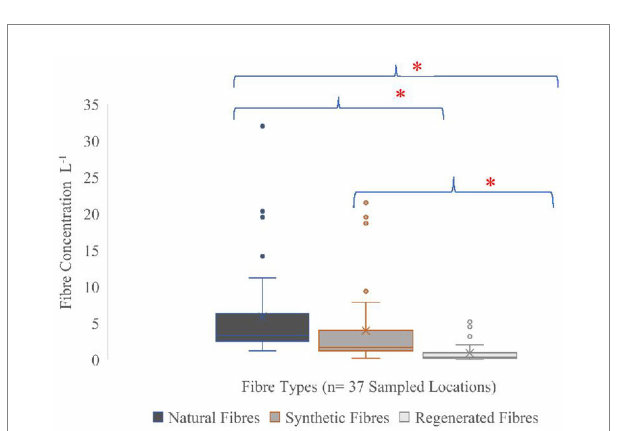
FIGURE 5 Concentrations of natural, synthetic and regenerated cellulosic fibres distributed across the 37 sampled locations. *Statistically significant difference at α = 0.05.